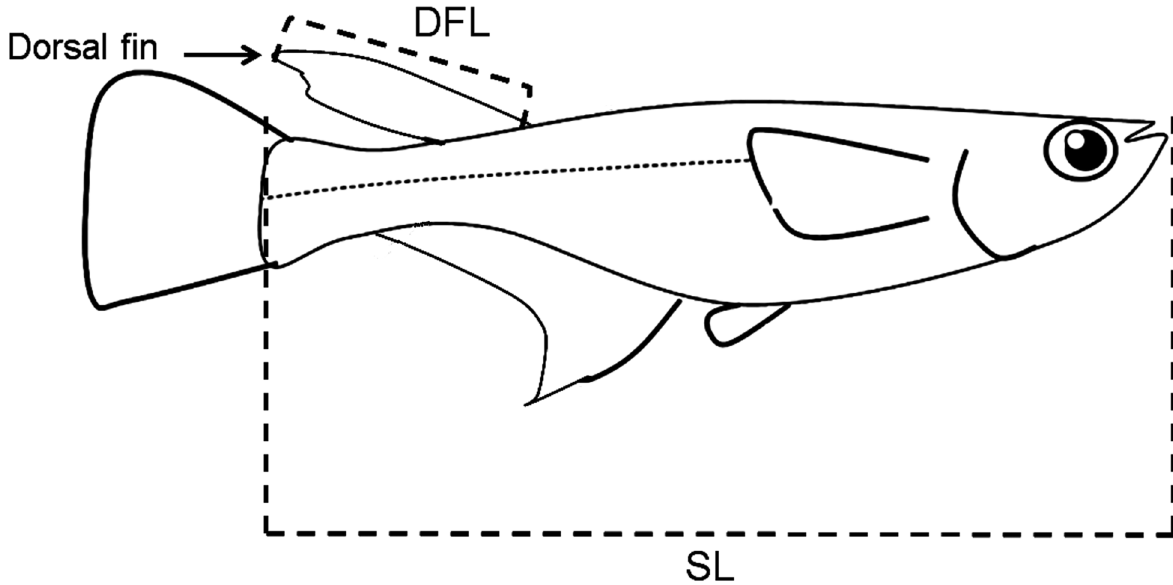
Fig. 1. Diagrammatic illustration of measurement of standard length (SL) of Thai medaka, Oryzias minutillus , and the length of its dorsal fin (DFL); CC = caudal peduncle